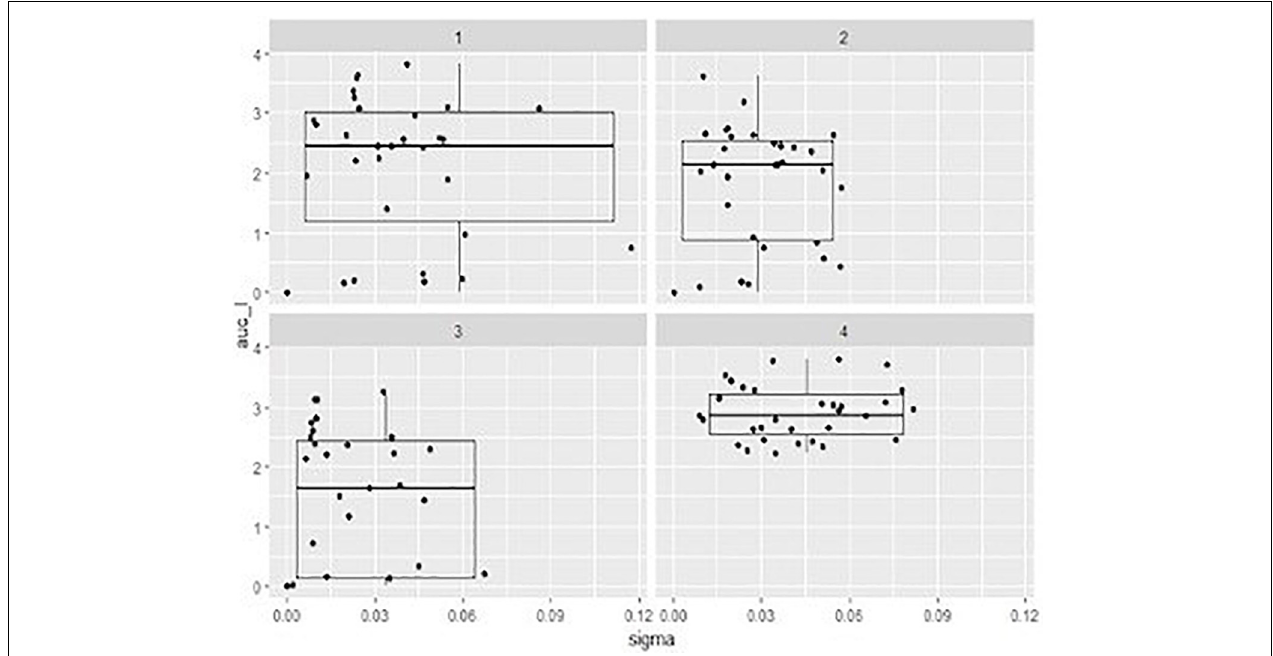
FIGURE 3 | Box-plots representing the distribution describing the of area under the curve (auc) values ont x axe and the sigma value (the residual sum of squares from the non-linear regression model) onto y axe showed by mixed suspensions of the phage cocktail with each STEC strain, at three different multiplicity of infection (MOI) and relevant sigma value. 1, MOI 0.1; 2, MOI 1 3, MOI 10; 4, positive